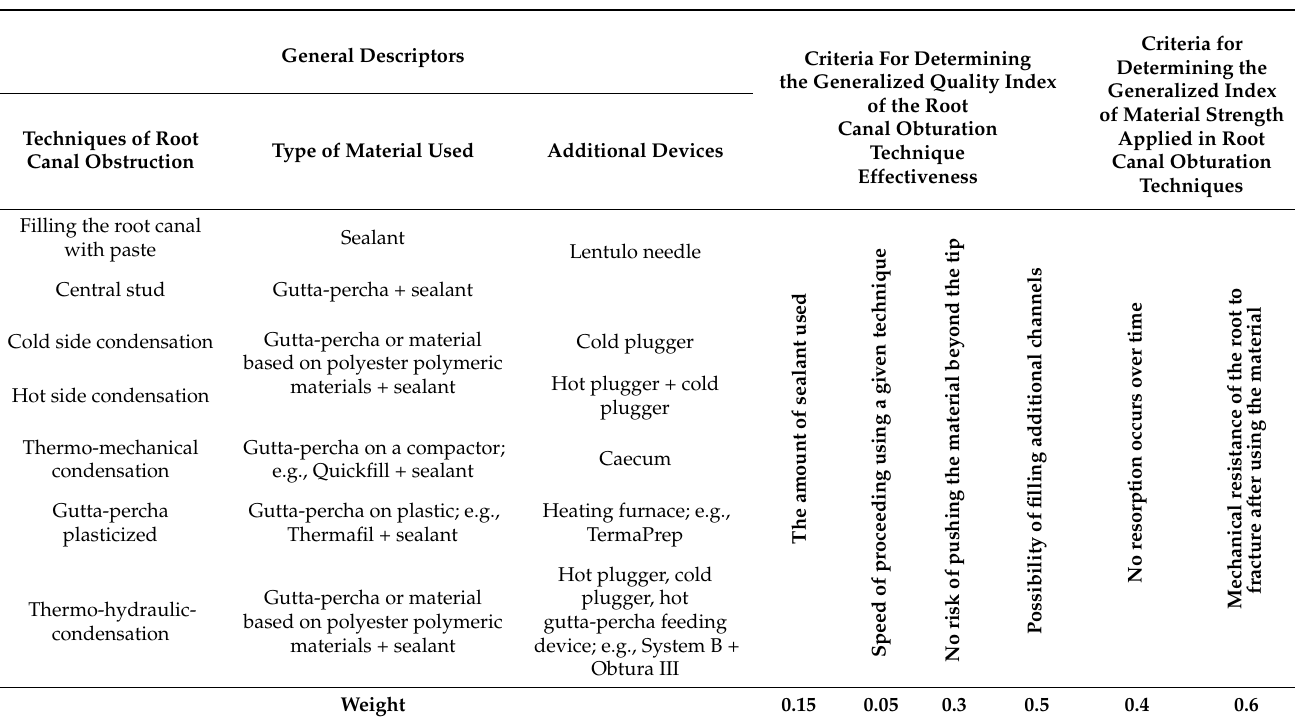
Table 4. The set of criteria adopted for the virtual contextual analysis concerning the selection of assessing the tightness of root canal fillings during endodontic treatment.